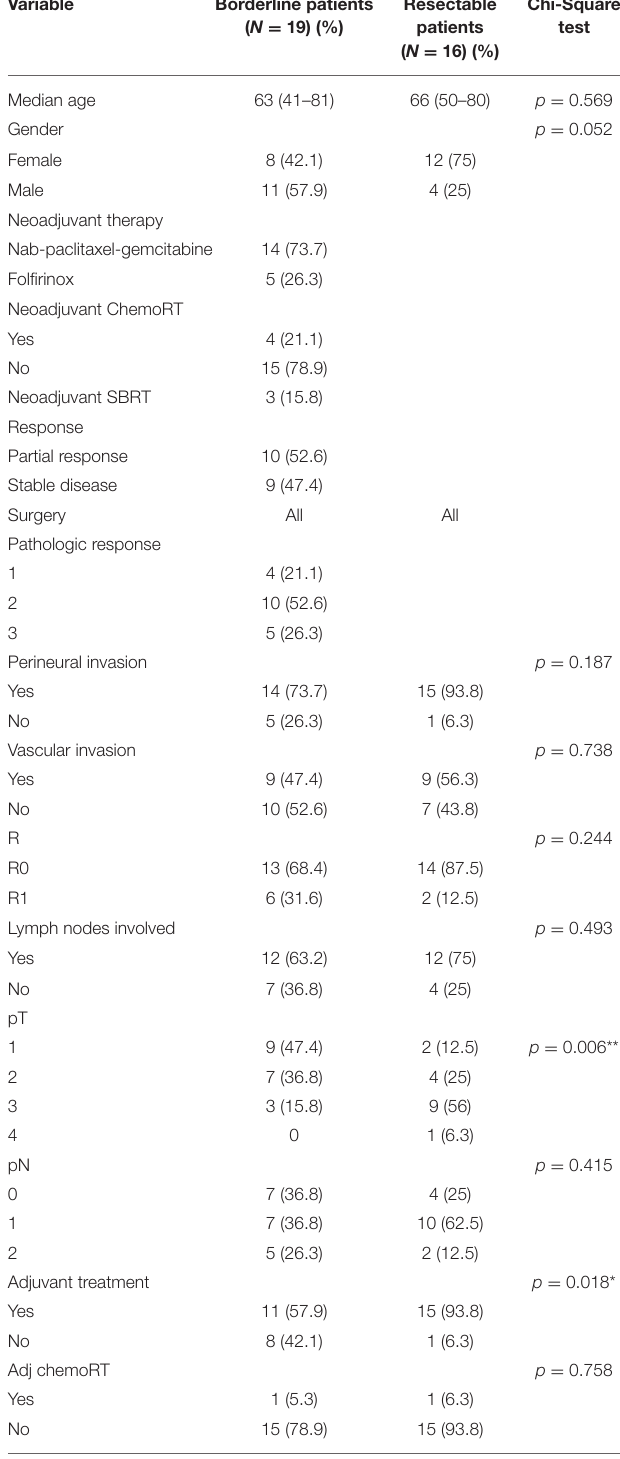
TABLE 1 | Clinical and demographic data of patients.